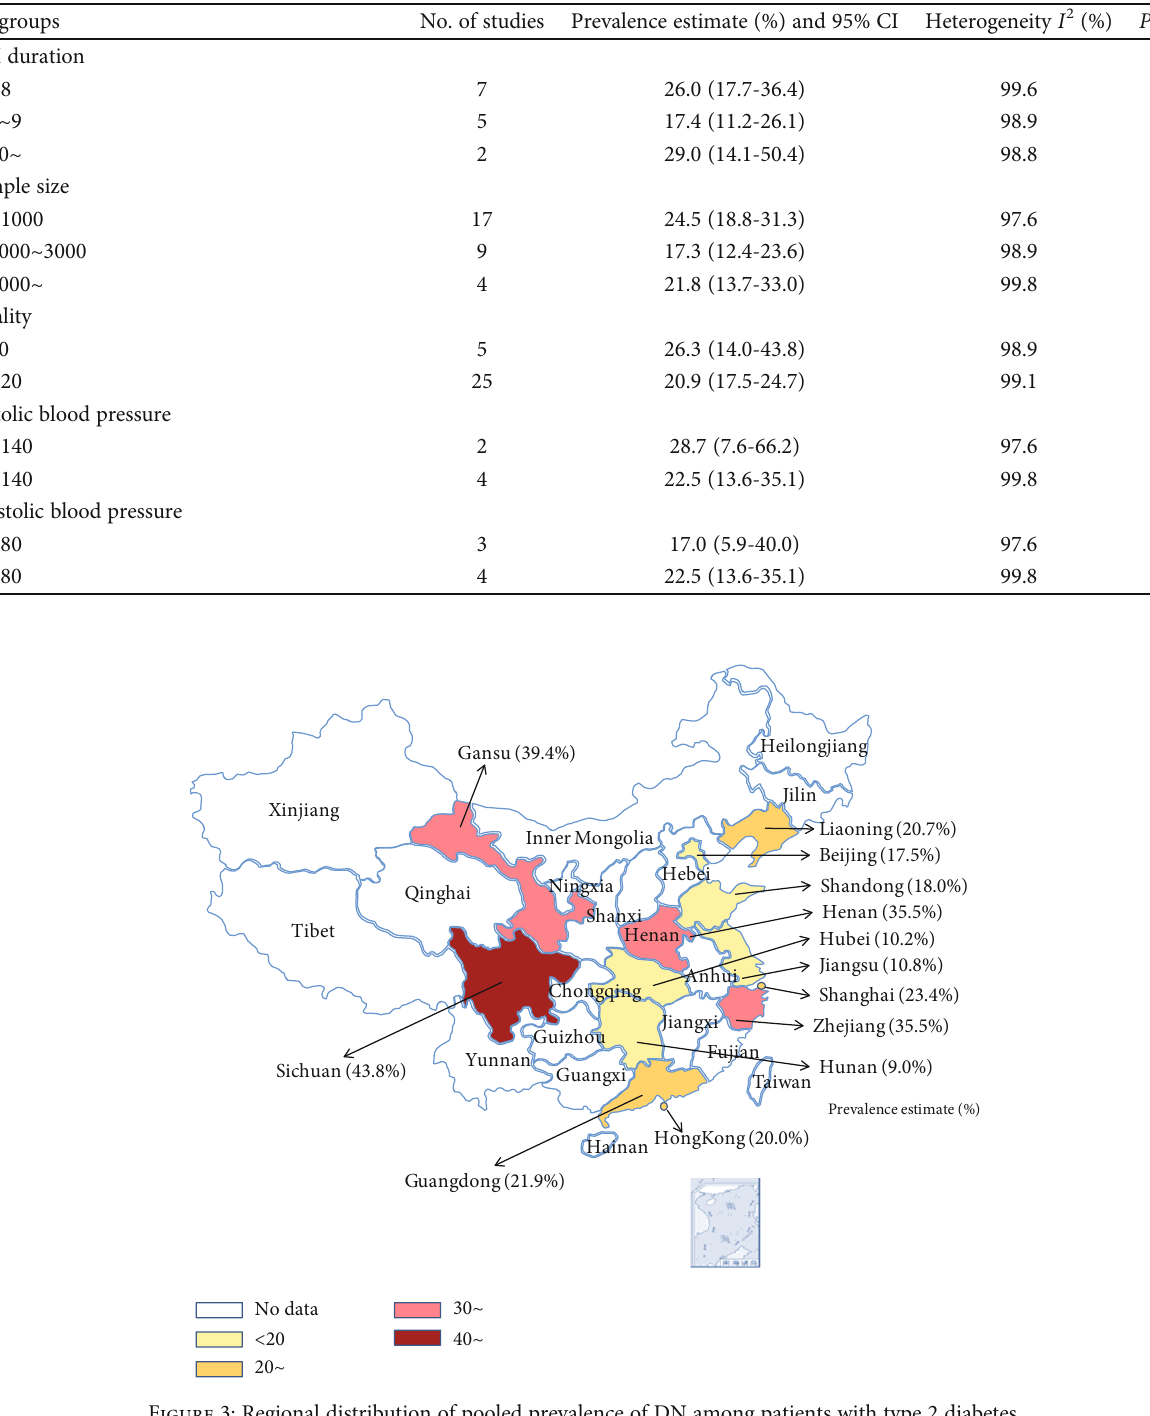
Figure 3: Regional distribution of pooled prevalence of DN among patients with type 2